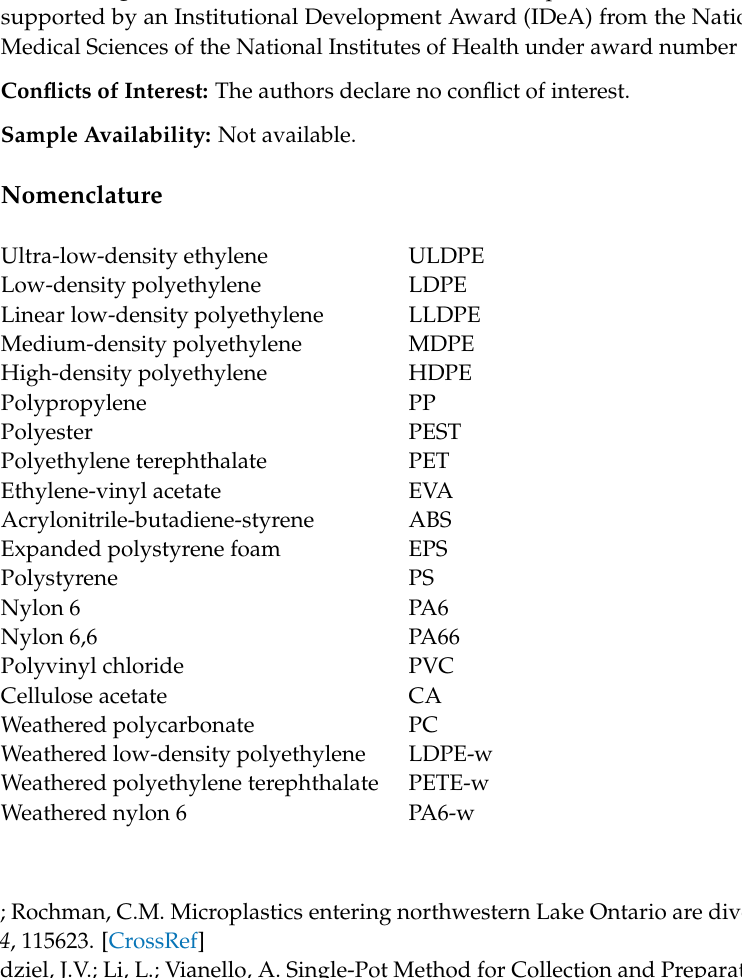
Table S1: Summary of polymers’ characteristics and sources; Table S2: Information of applied dyes; Table S3: Step-by-step procedure for staining of microplastics with fluorescent